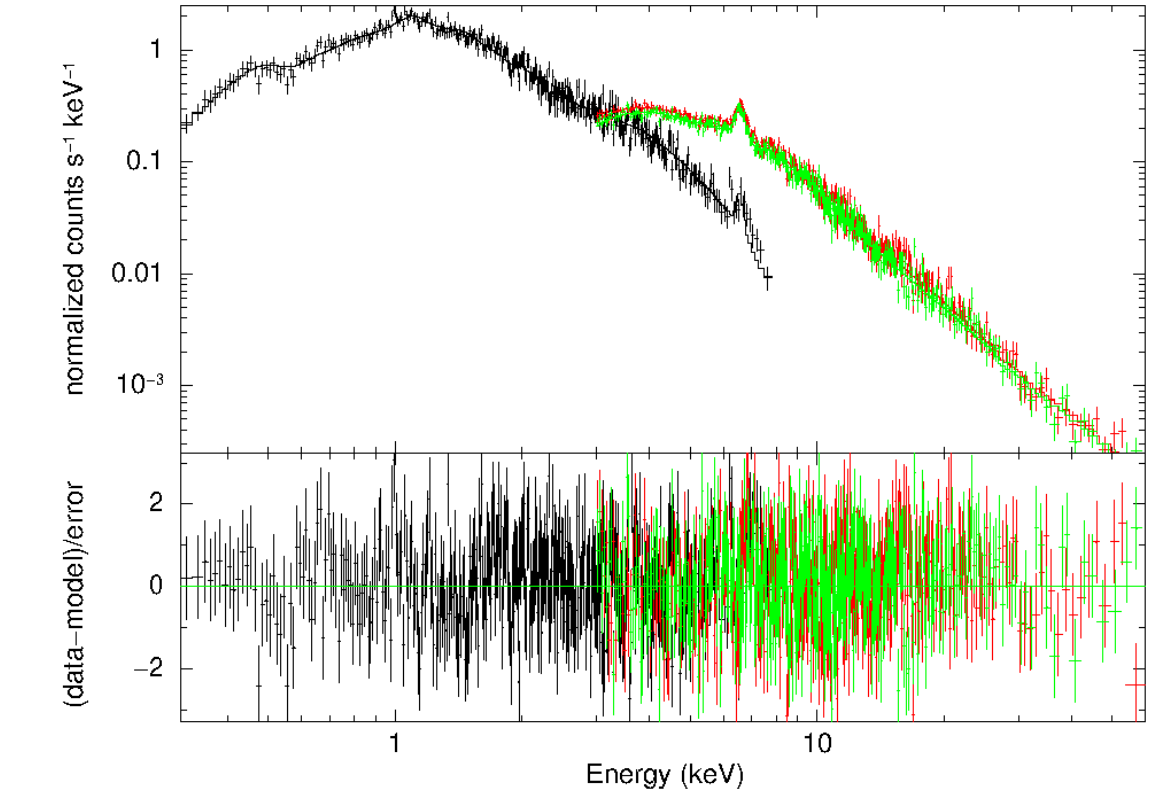
Figure 2. Top panel: XRT and NuSTAR data, from circular region with radius 1’ centred on the location of the source, fitted with tbabs(apec + powerlaw) for data from 3 November 2015 observations. Bottom panel: residuals in terms of sigmas. In both the panels, red and green datasets correspond to NuSTAR FPMA and FPMB,